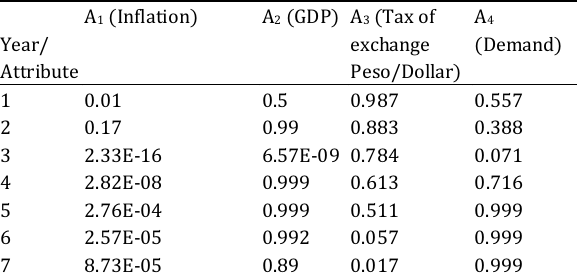
Table 3. Truth values of the elements of the Mexican Economy in Table 2